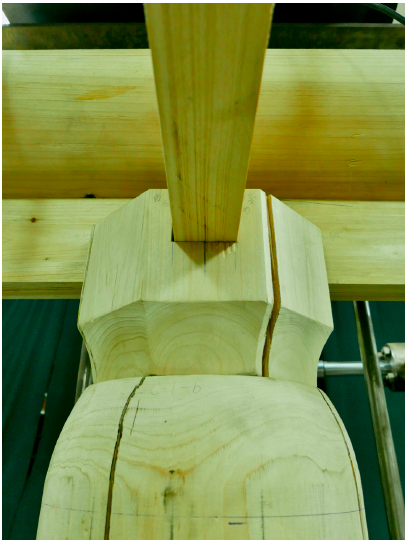
Figure 2. Zuo-Dou joint.